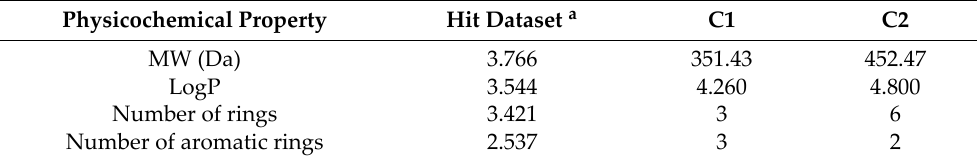
Table 1. Chemoinformatics analysis for hit dataset, C1, and C2 after the virtual screening. Physicochemical